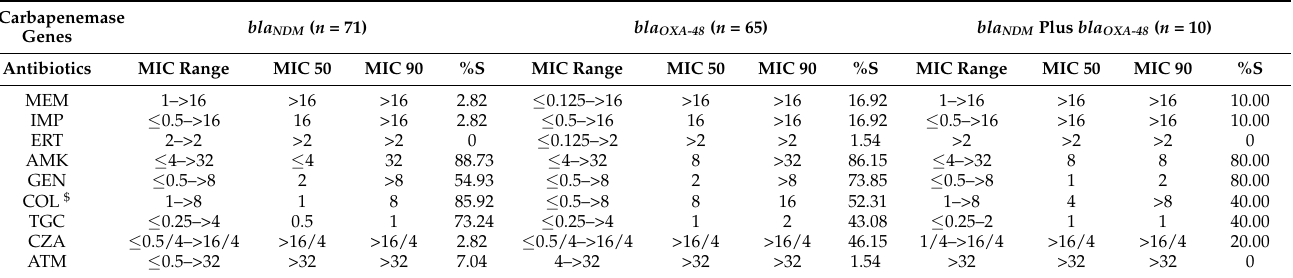
Table 3. Susceptible rates, MIC range, MIC 50 and MIC 90 of all antibiotics grouped by type of carbapenemase